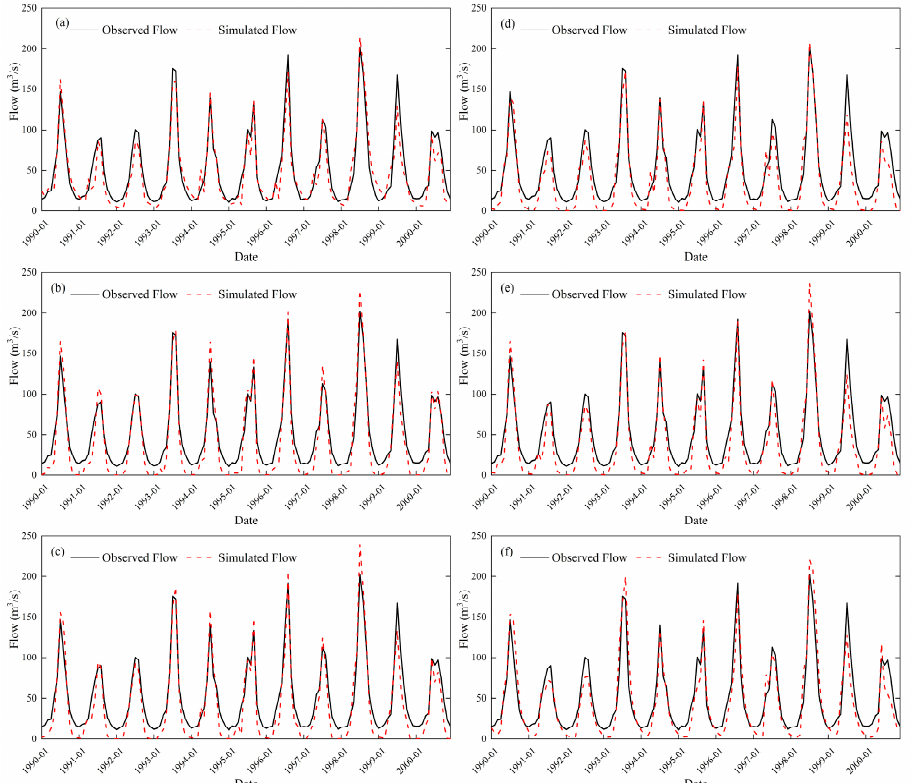
Figure 13. Comparison of simulation results with the observed streamflow in the simulation periods (1990–2000). ( a ) Calibrating ten key parameters integrated the results of four analytical methods (C10);